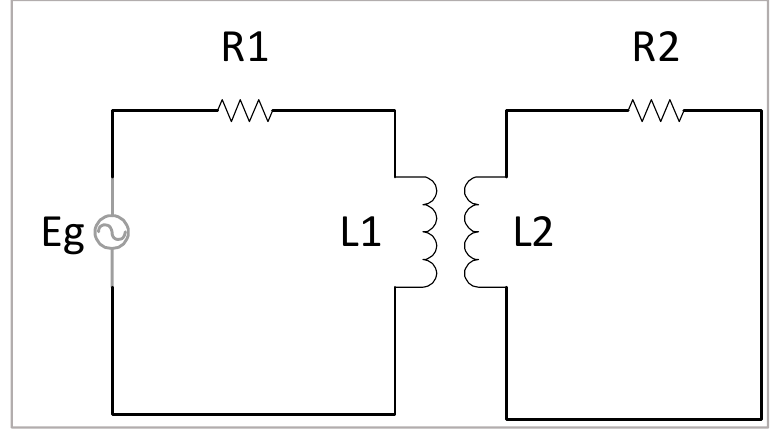
Figure 12. Transformer presentation of the coil and of the workpiece.